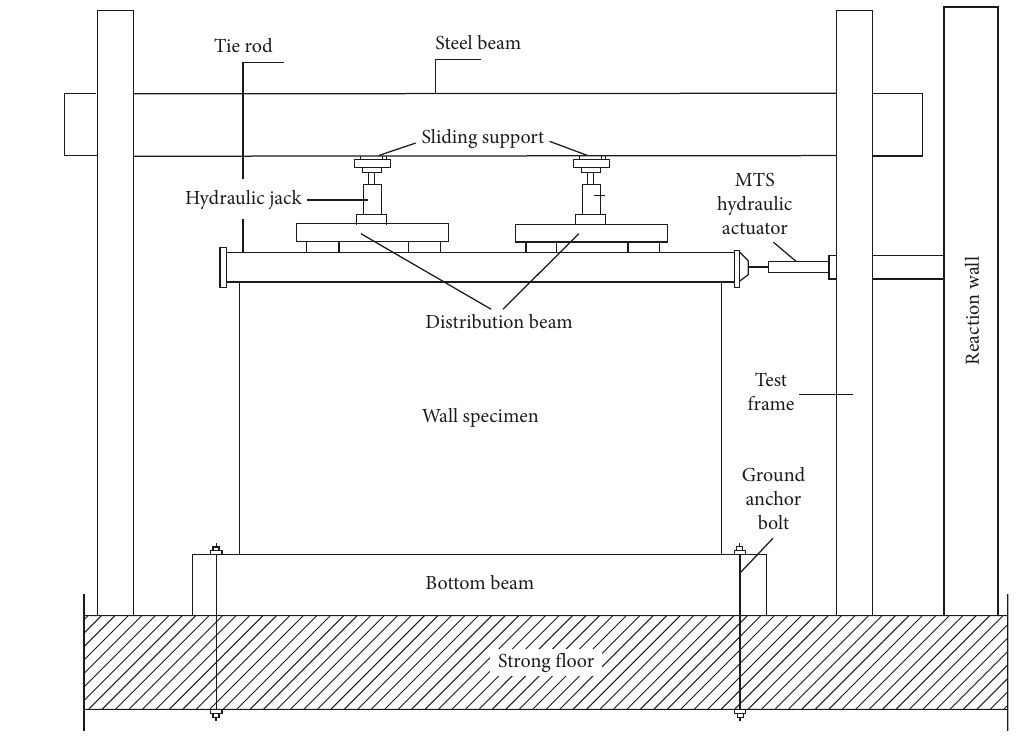
Figure 5: Schematic diagram of the test loading device.